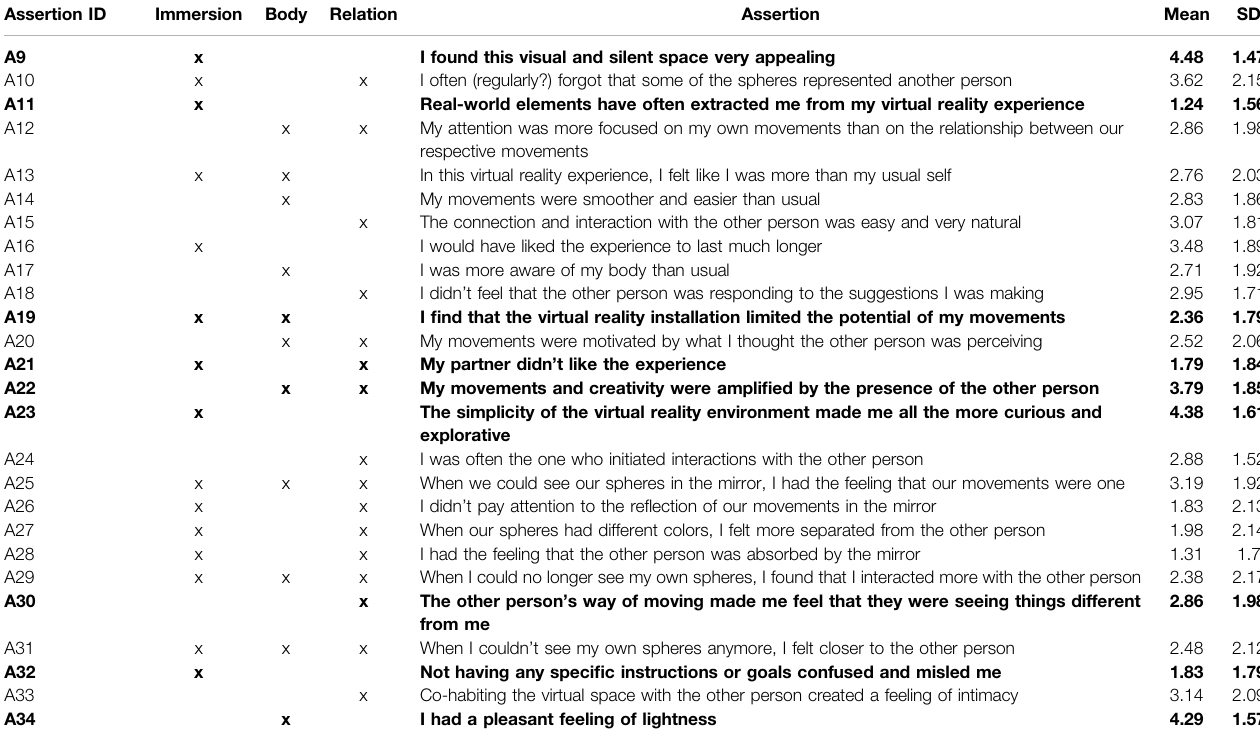
TABLE 1 | Categories and quantitative results of post-experiential questionnaires. Assertion